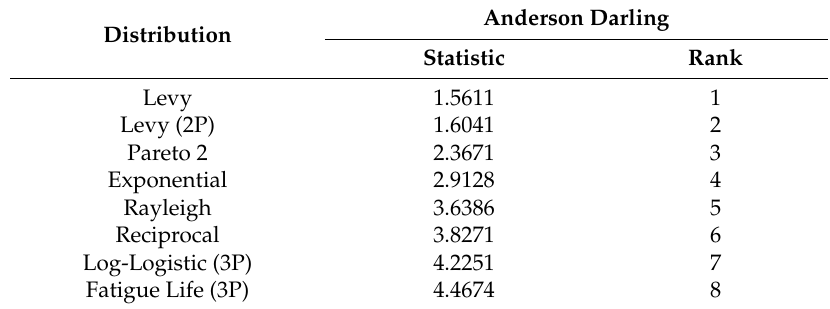
Table 4. Results of statistical tests for determining the fitting of service times to a certain distribution.